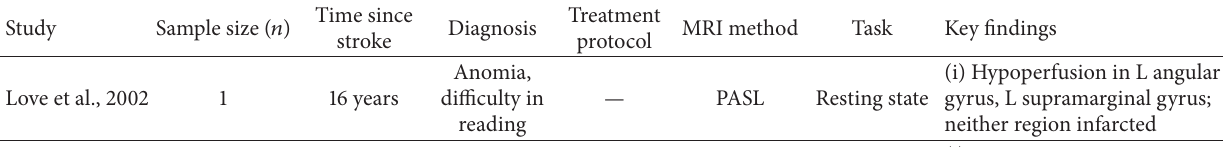
Table 1: Studies of perfusion in chronic